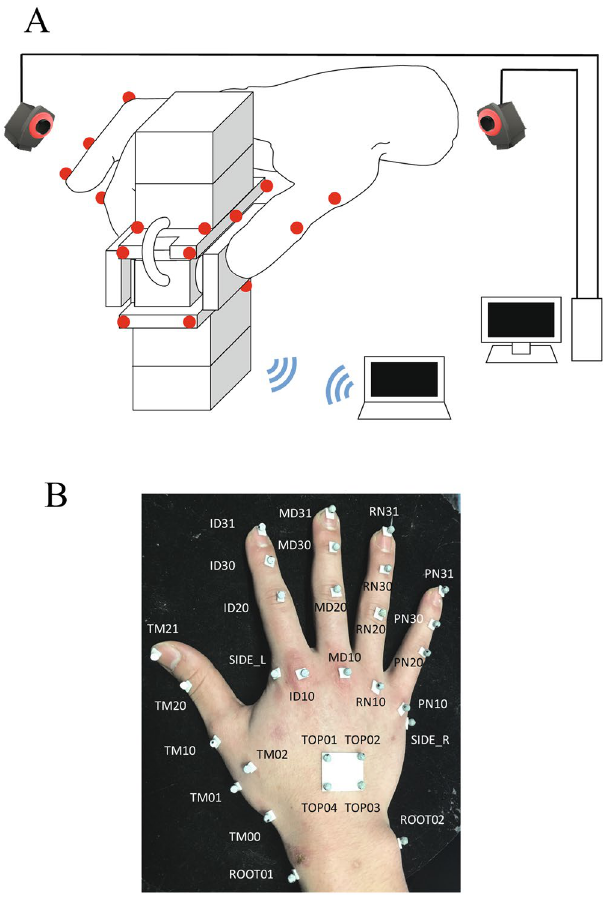
Figure 5. Measurement of hand kinematics using a motion capture system ( A ) and placement of reflective markers on the dorsal surface of the hand ( B